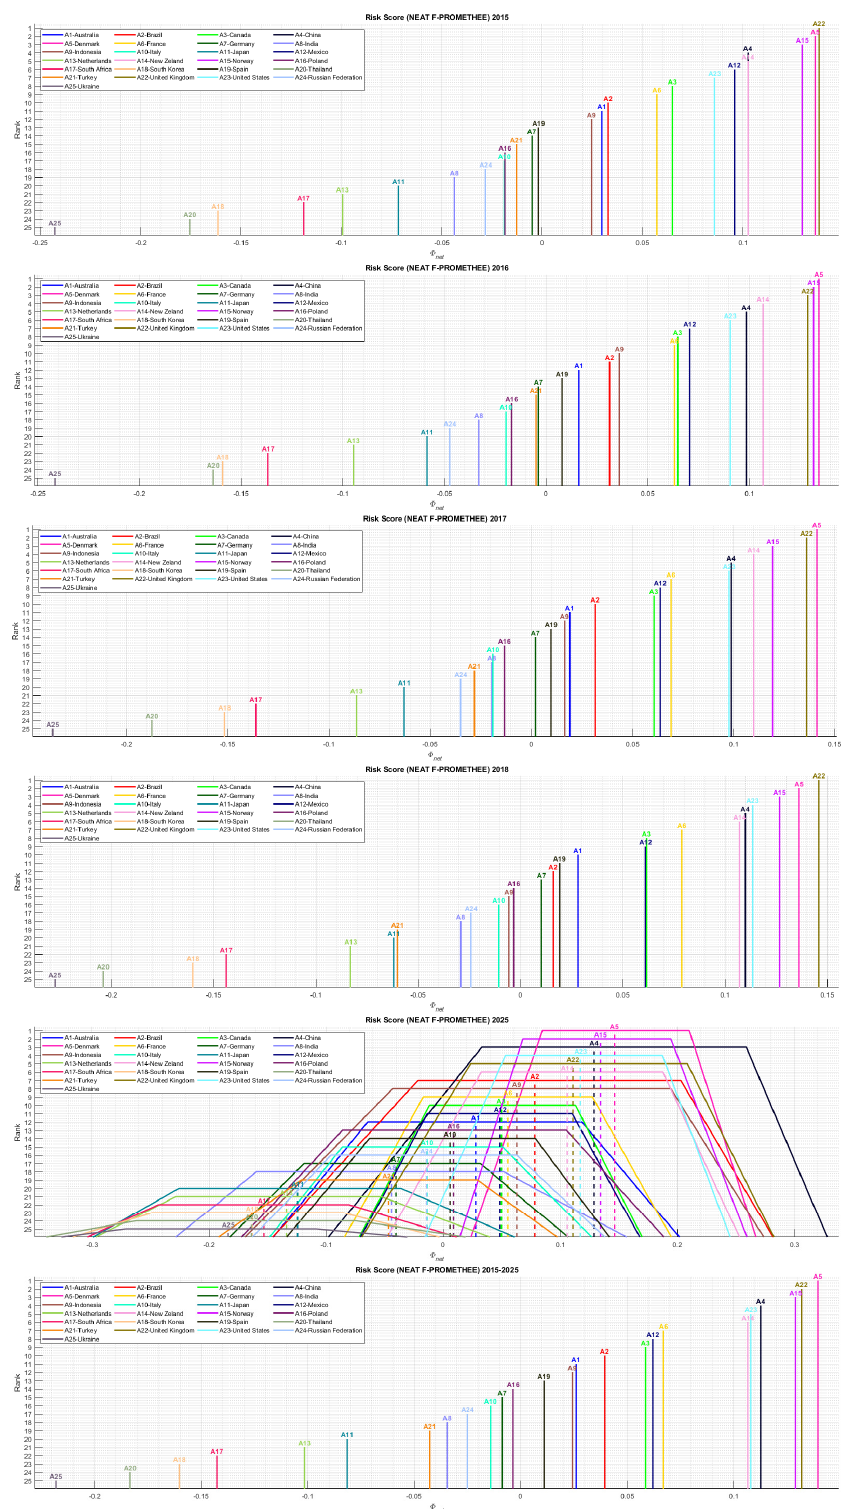
Figure 3. Energy security rankings obtained using a coherent criteria family and the NEAT F-PROMETHEE II method.